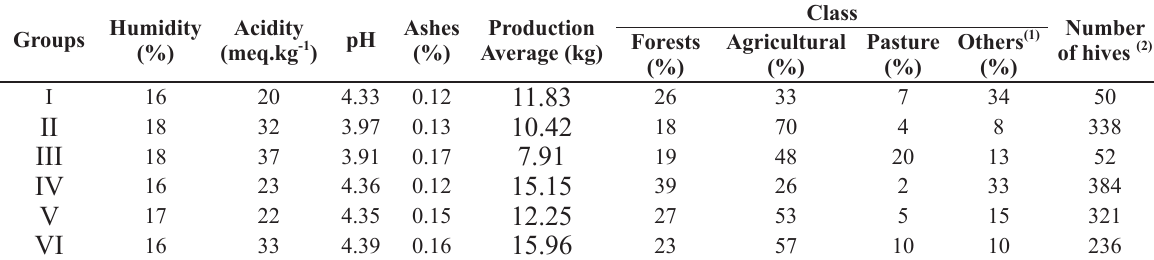
Average results of physicochemical analyzes of honey samples, the use and occupation of the ground around the hives within a radius of three Kilometers and the average data for production of the second